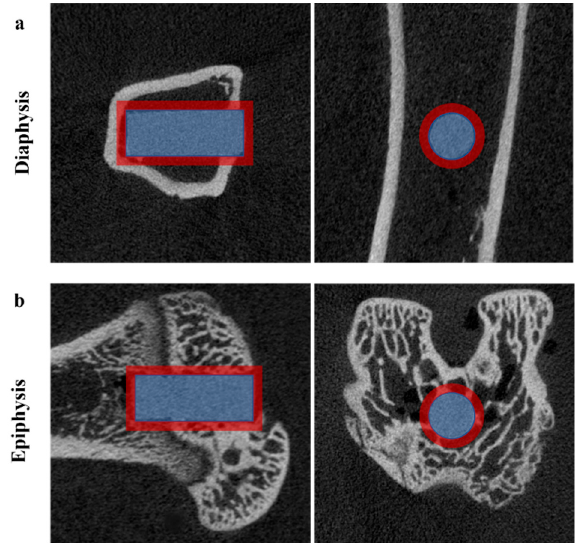
Figure 2. The region of interest (ROI) determines the volume of the Mg rod (blue cylinder) and new bone volume (red annular cylinder). The images from the micro-CT scan were analyzed by CTAn software in the axial and sagittal planes of the Mg implantations in ( a ) the tibial diaphysis and ( b ) distal femoral epiphysis.